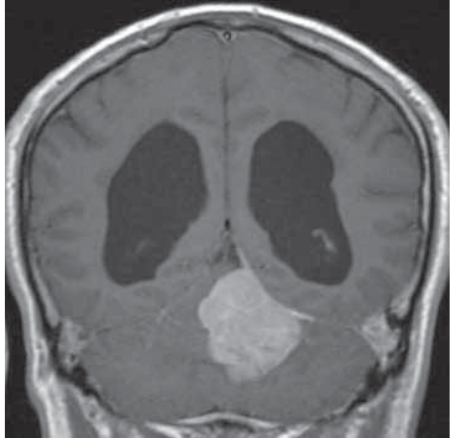
FIGURE 1. The coronal contrast-enhanced T1-weighted im- age shows a right temporal meningioma with the “dural tail sign” below and lateral to the lesion, along the right tentorium.